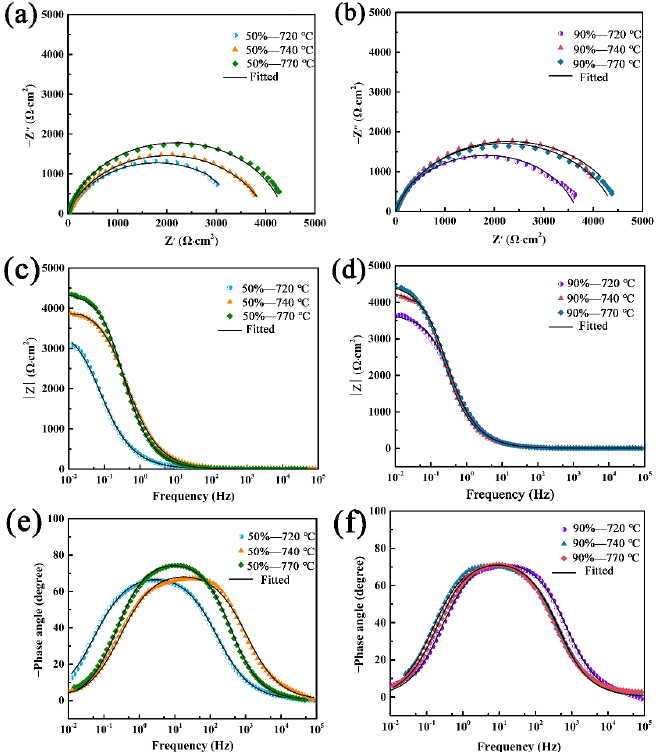
Figure 14. EIS plots of X2CrNi12 specimens with 50% and 90% cold-rolling reduction at different annealing temperatures: ( a , b ) Nyquist plots, ( c , d ) Bode impendence plots, ( e , f ) Bode phase angle plots.